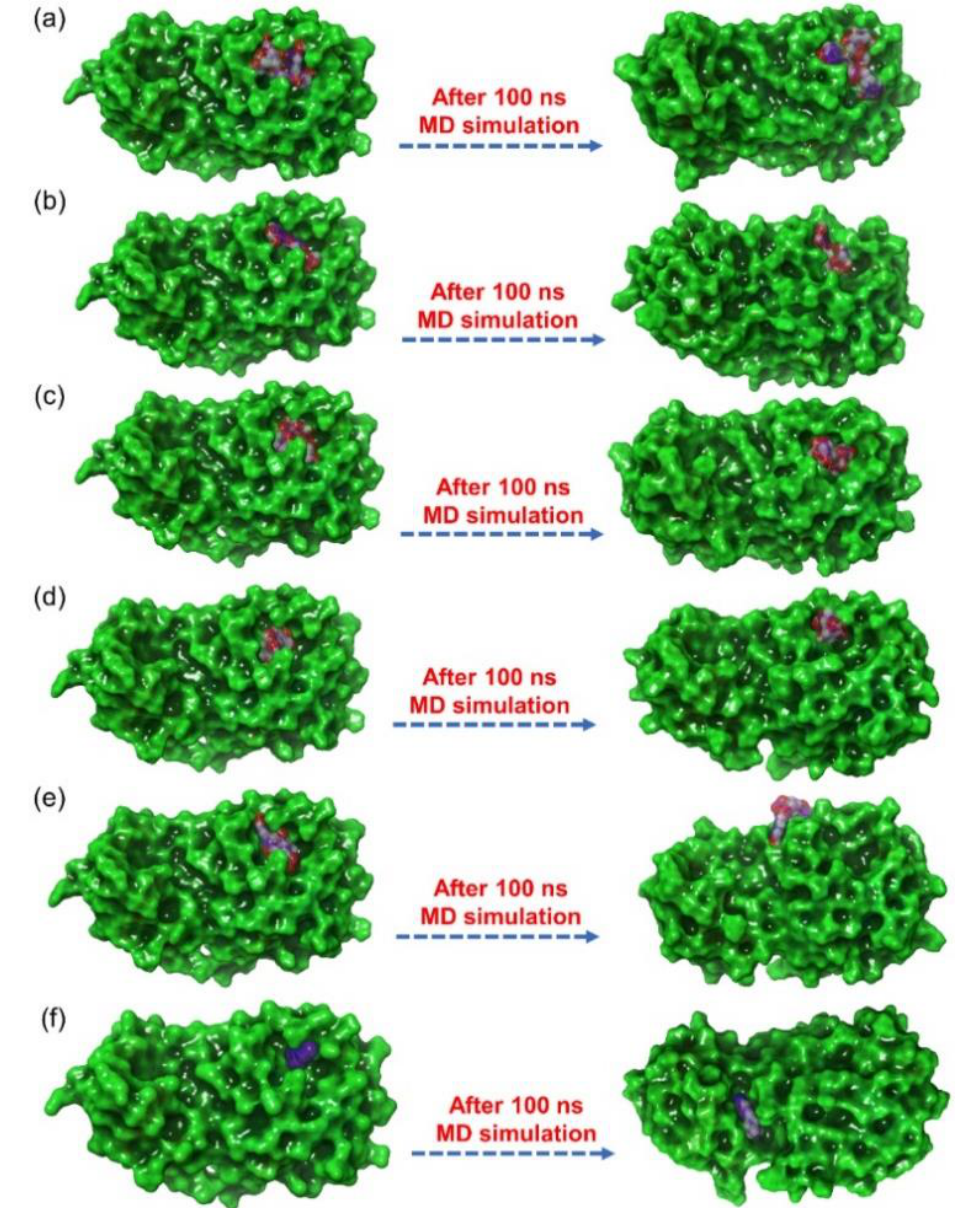
Figure 5. 3D docked poses of SARS-CoV-2 M pro -natural products, i.e., ( a ) Echinacoside, ( b ) Quercetagetin 7-glucoside, ( c ) Levan N, ( d ) Inulin from chicory, and ( e ) 1,3-Dicaffeoylquinic acid, and ( f ) 6-(ethylamino) pyridine-3-carbonitrile, exhibiting transition of docked poses through 100 ns MD simulation.